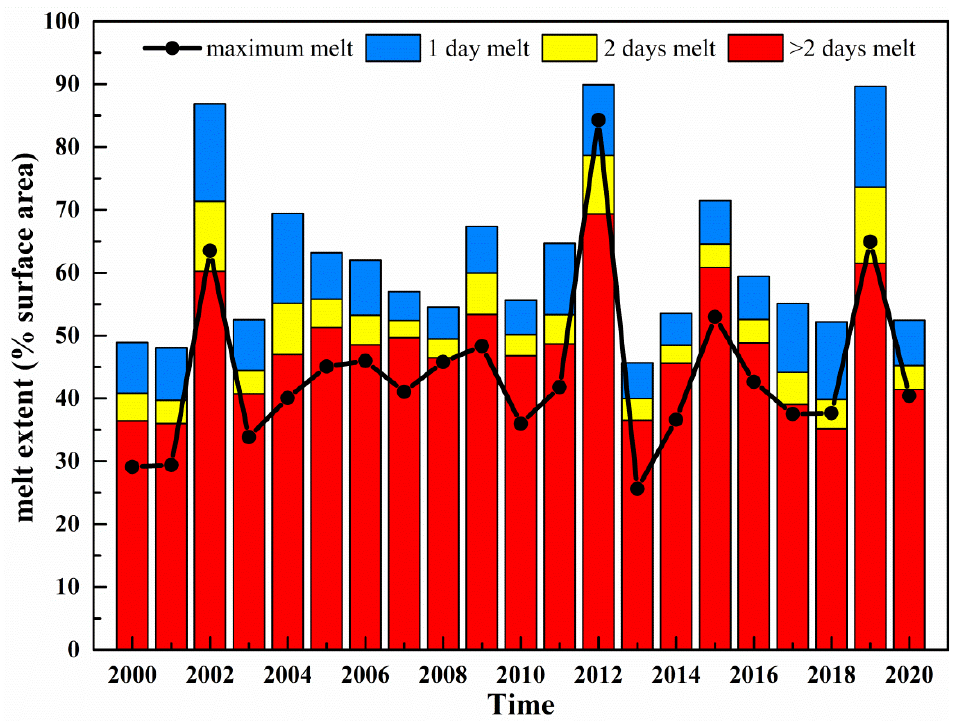
Figure 7. Percentage of the GrIS melting extent for summer from 2000 to 2020. (Extent of maximum melt as derived from the MODIS daily LST).